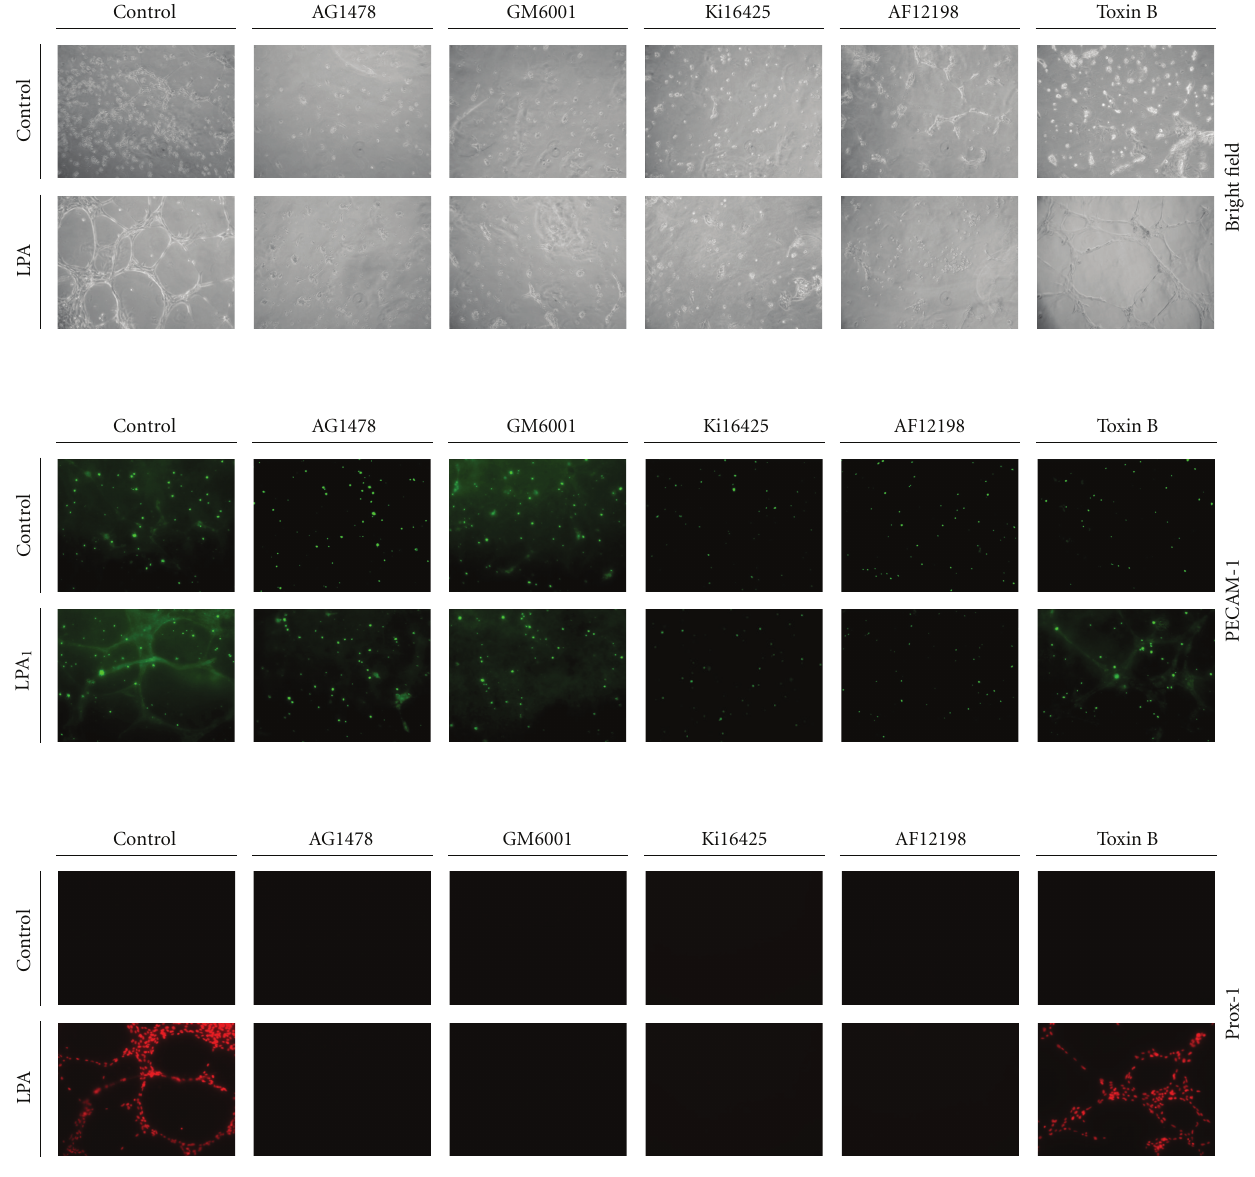
Figure 4: Lysophosphatidic acid- (LPA-) stimulated endothelial cell tube formation in vitro is mediated through endothelial growth factor receptor (EGFR) transactivation-, matrix metalloproteinase- (MMP-), LPA1/3-, and interleukin- (IL-) 1R-dependent mechanisms. Starved HUVECs were pretreated with AG1478 (100nM), AF12198 (10nM), GM6001 (10 μ M), Ki16425 (10 μ M), and toxin B (10nM) for 1 h, followed by LPA (5 μ M) treatment for an additional 24 h, and then cells were seeded onto Matrigel-coated plates. After 6h of plating, Matrigel of each experiment was fixed and subjected to an immunocytochemical assay. The Matrigel was stained with PECAM-1 or a Prox-1 primary antibody followed by an FITC-conjugated secondary antibody. Images were taken after plating and visualized by immunofluorescence